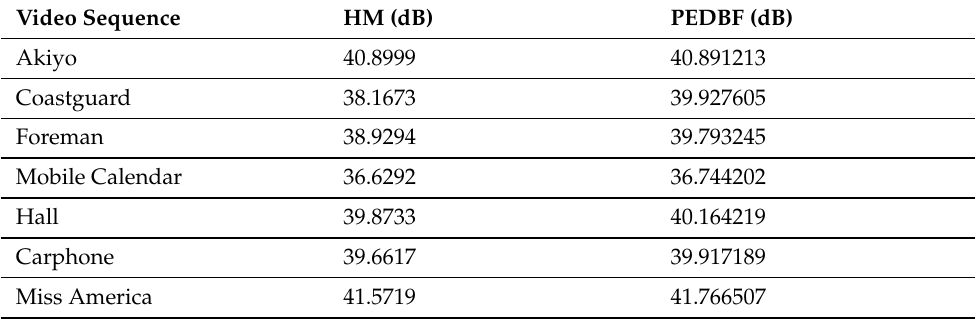
Table 9. PSNR of QCIF video sequences with QP = 27.